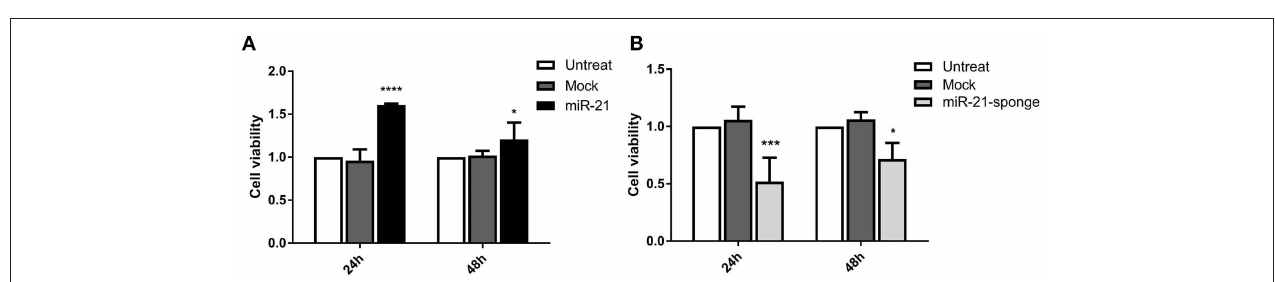
FIGURE 5 | Cell viability assay in the U87-MG cells exposed to the engineered exosomes. (A) The MTT assay (MTT absorbance at 570nm) demonstrated a significant increase in the cell viability of U87-MG cells treated with miR-21 enriched exosomes ( P < 0.0001 at 24h, and P < 0.05 at 48h). (B) MTT absorbance in U87-MG cells revealed a significant decreased in cell viability, in the cells exposed to the miR-21-sponge containing exosomes ( P < 0.001 at 24h, and P < 0.05 at 48h). The cells exposed to the mock-vectors containing exosomes were used as controls. * P < 0.05; *** P < 0.001; **** P < 0.0001, which is represented by some statistical software like Graph